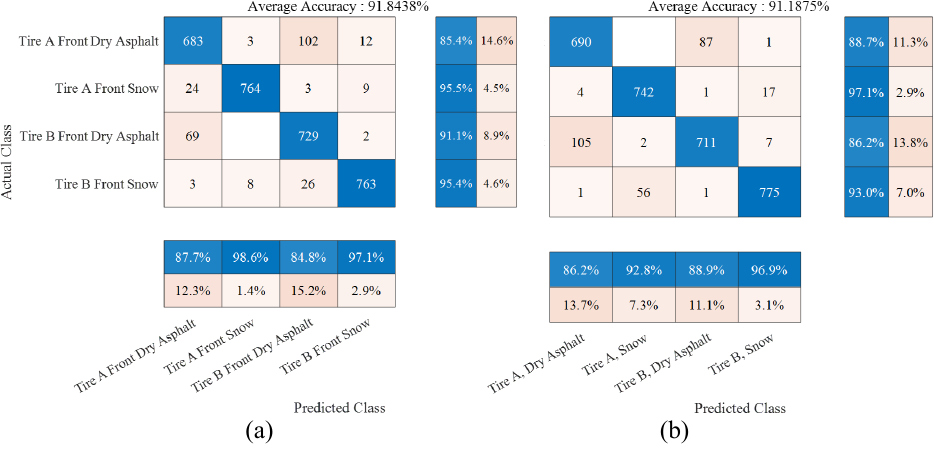
Figure 12. Convergence curve of loss during train process for 4 class classification using front-wheel data.